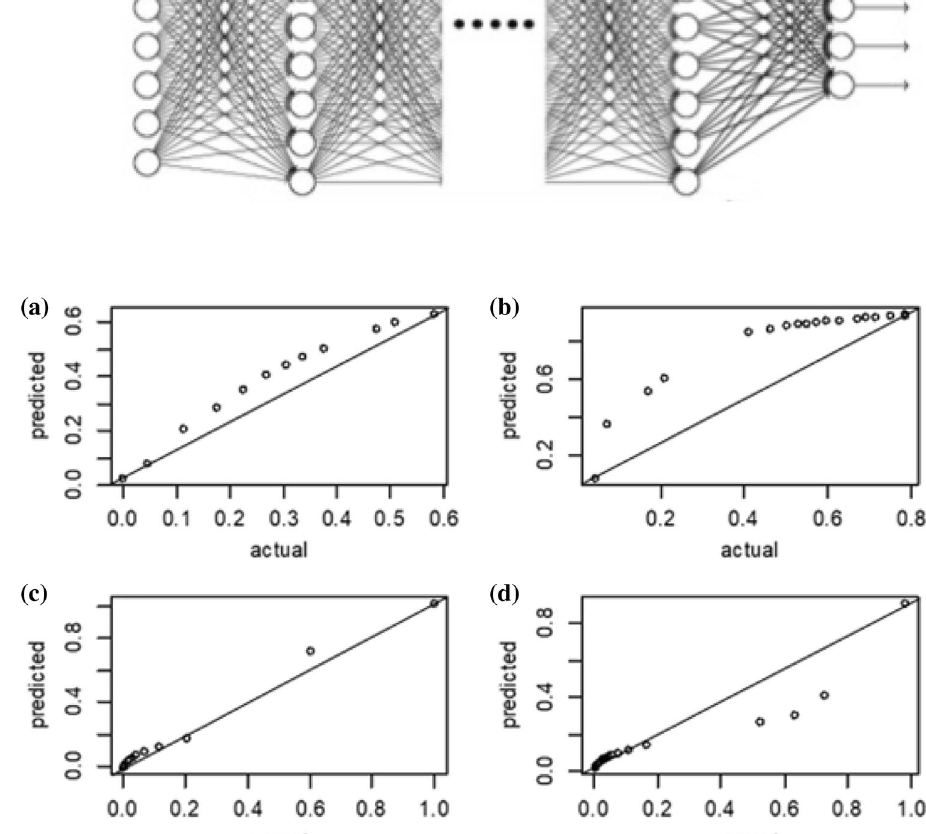
Fig. 3 Deep neural network model architecture showing input, hidden and output layers (Lee et al. 2017)